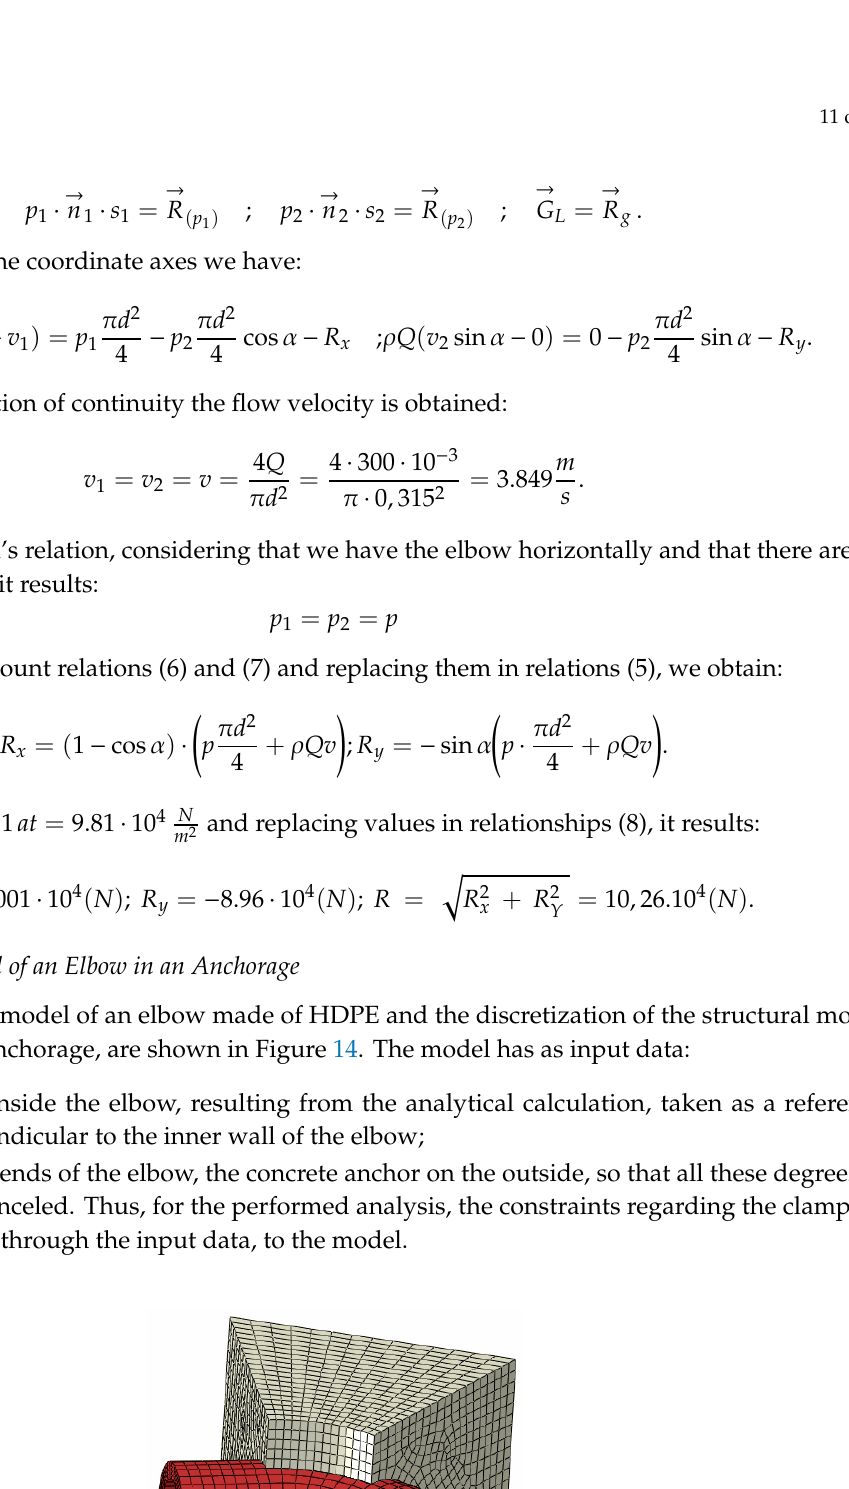
( b ) Figure 15. ( a ) Stress field in the assembly elbow-massif ( b ) Stress distribution in a section of the assembly. The stresses occurring in the concrete massif are represented in Figure 16, in MPa.